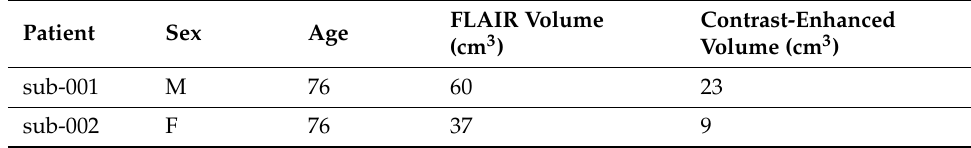
Table 1. Population